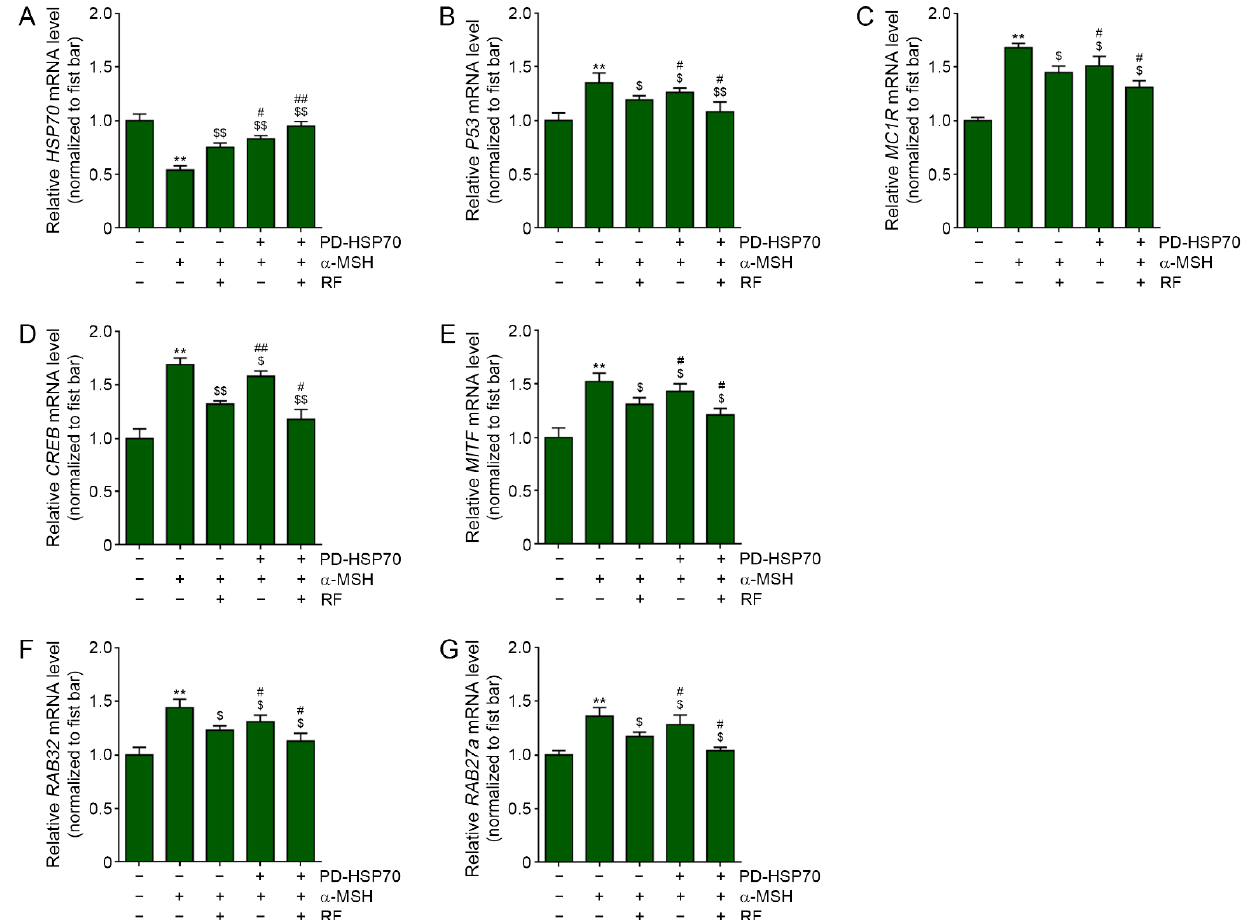
Figure 4. Effects of RF effect on decreasing melanogenesis in HSP70-overexpressed HEMn cells ( A – G ). HSP70 ( A ), p53 ( B ), MC1R ( C ), CREB ( D ), MITF ( E ), RAB32 ( F ) and RAB27a ( G ) mRNA levels of α -MSH and PD-HSP70 or untreated melanocytes were evaluated by qRT-PCR. HSP70, 70 kilodalton heat shock proteins; MC1R, melanocortin 1 receptor; MITF, microphthalmia-associated transcription factor; Rab32, ras-related protein Rab-32; Rab27a, ras-related protein Rab-27a; RF, radiofrequency; UV-B, ultraviolet-B; **: p < 0.01 vs. PBS; $: p < 0.05, $$: p < 0.01 vs. α -MSH/RF ( − ); #: p < 0.05, ##: p < 0.01 vs. α -MSH/RF